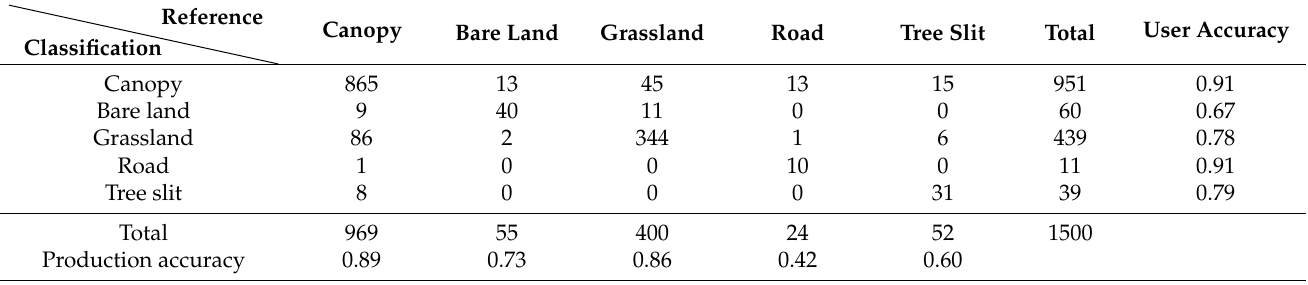
Table 6. An analysis of the accuracy of classification results of Shenxiantang tiankeng.